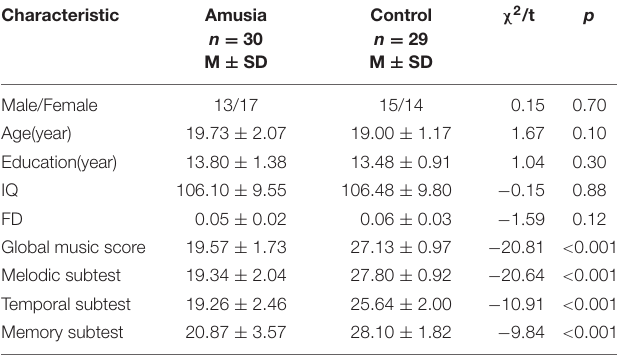
TABLE 1 | Characteristics of study participants by